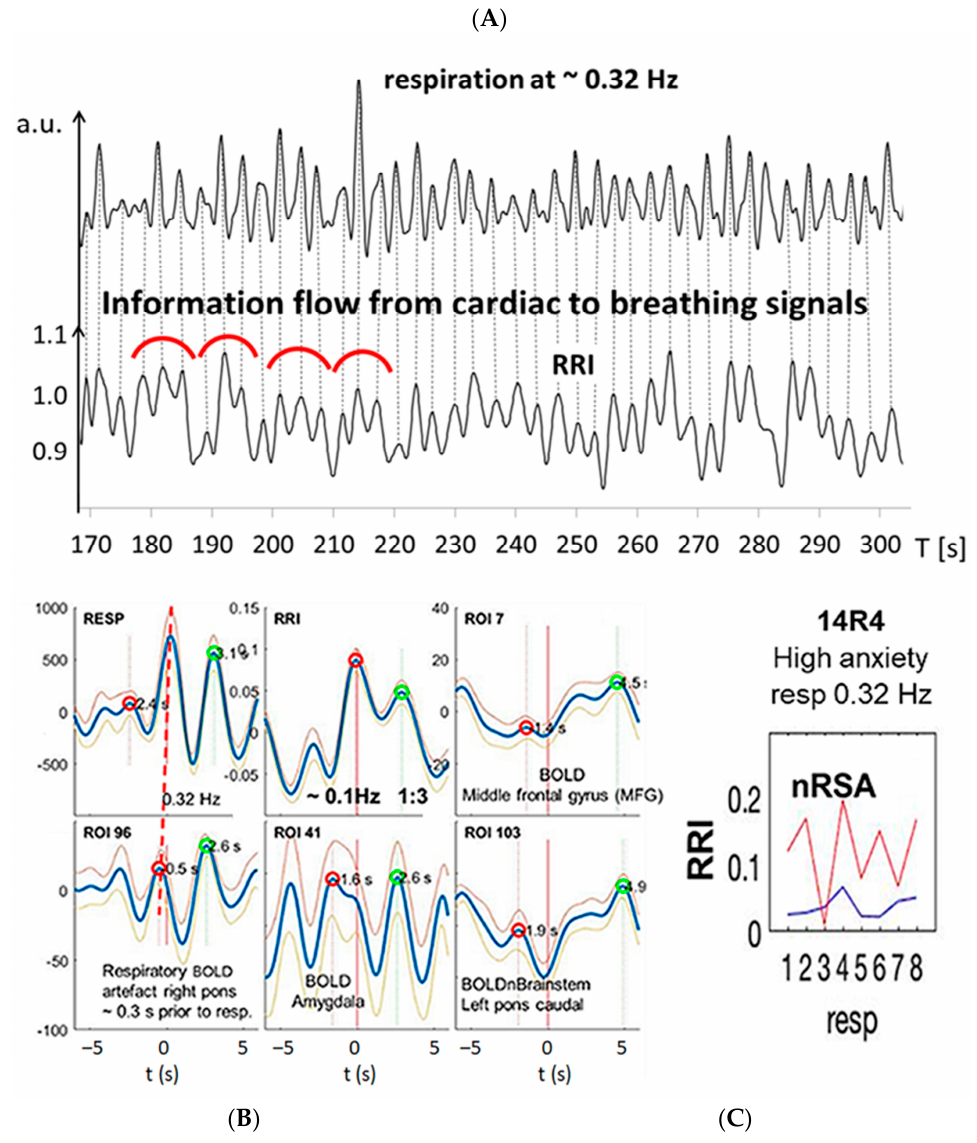
Figure 5. Example from subject #14 with dominant fast respiration in the 0.2–0.4 Hz band. ( A ) Records of respiratory and RRI waves. Some RRI periods with 1:3 coupling are marked with red semi-circles, indicating superposition of fast wavelets at ~0.3 Hz originating from the respiratory rhythm on slow RRI waves at ~0.1 Hz. ( B ) RRI peak (longest RR interval)-triggered respiratory (resp), RRI and slow BOLD waves (mean ± SEM; more details, see text). ( C ) The information flow diagram indicates a predominant flow from RRI to respiration. For further explanations, see Figure 3.